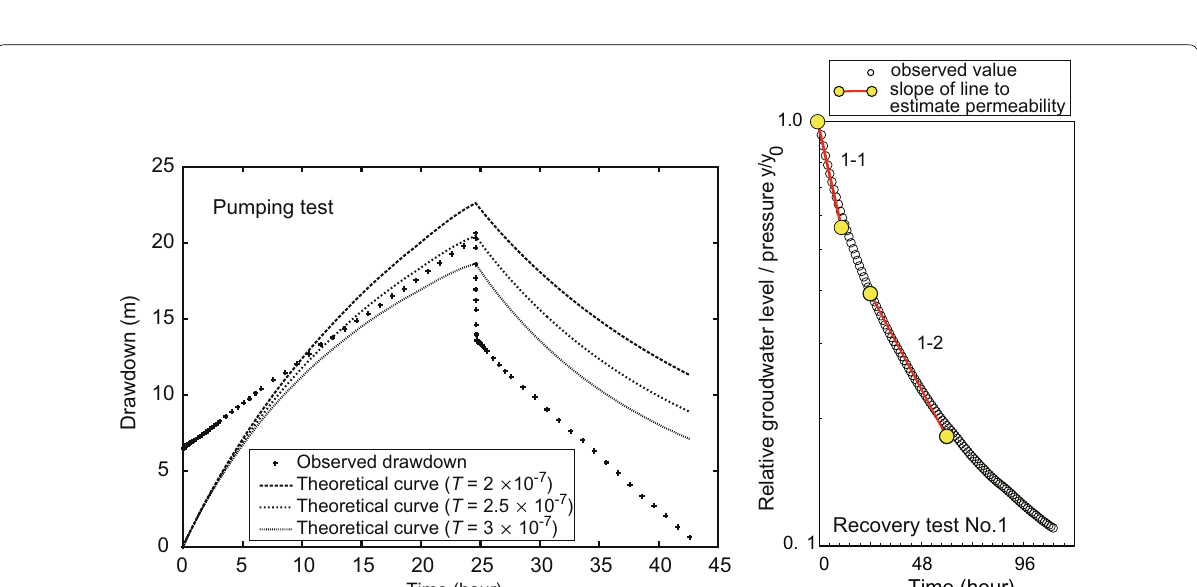
Fig. 4 Left: observed drawdown during pumping test at Hole 2 and theoretical drawdown curves for transmissivity values in m 2 /s. Right: results of the recovery